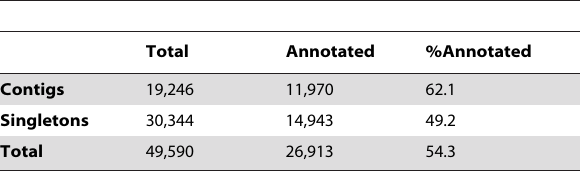
Table 1. Number of contigs and singletons obtained and successfully